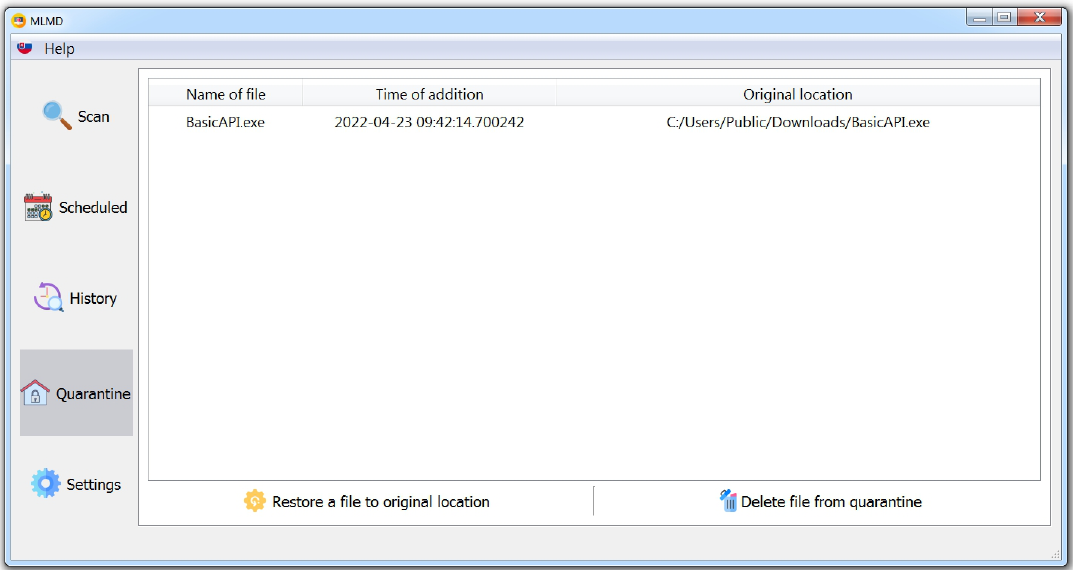
Figure 10. The quarantine screen.